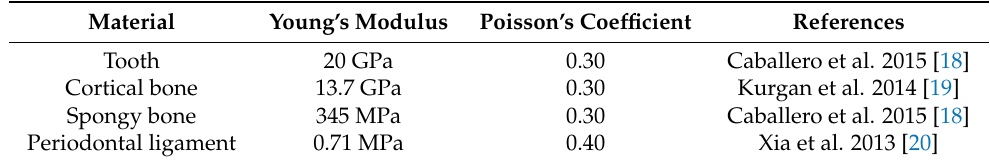
Table 2. Material